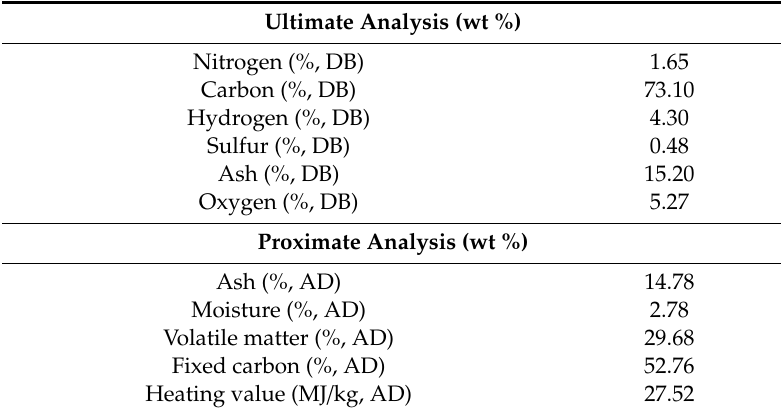
Table 1. Properties of Australian coal (AD: air-dried; DB: dry basis).